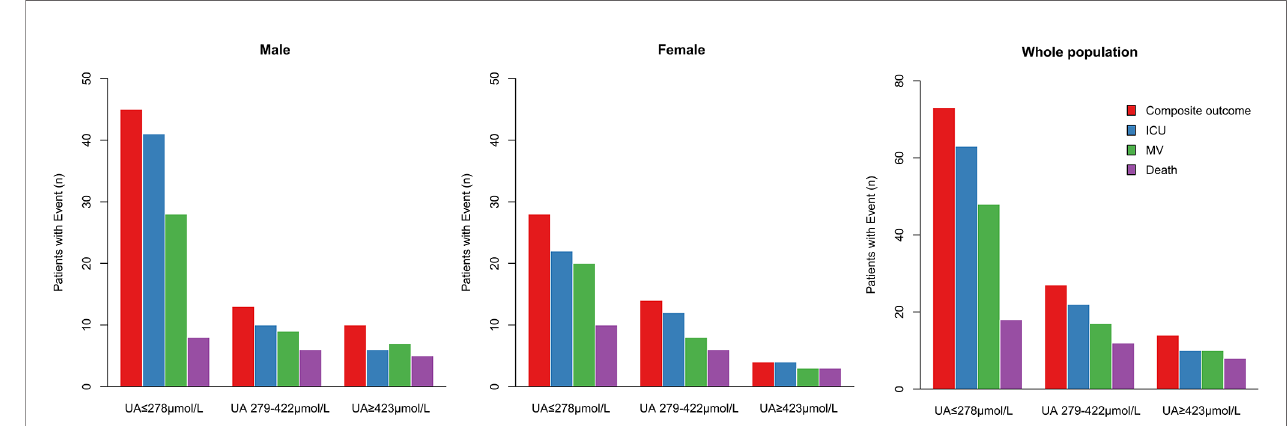
FIGURE 1 | Distribution of males, females and whole population of COVID-19 patients reaching the composite outcome, ICU admission, mechanical ventilation, or death relatively to uric acid concentrations. Distribution of patients ’ outcomes in the three ranges of serum uric acid concentrations from low to high (UA ≤ 278 m mol/L, UA 279 – 422 m mol/L, ≥ 423 m mol/L). ICU, intensive care unit; MV, mechanical ventilation.